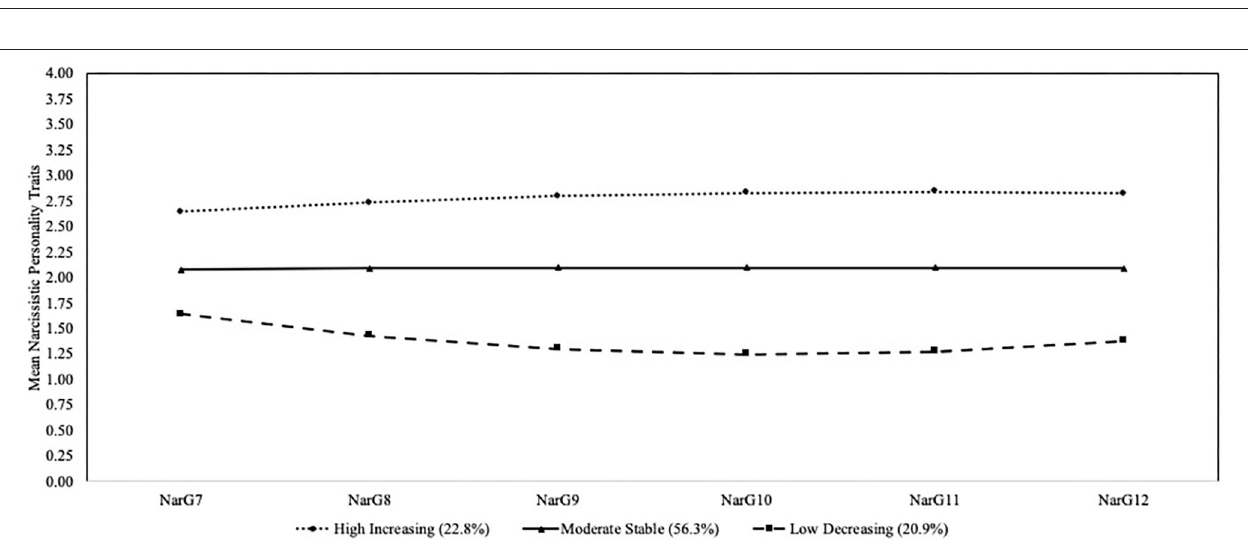
FIGURE 2 | Developmental trajectories of narcissistic personality traits. Nar, narcissistic personality traits; G, grade.